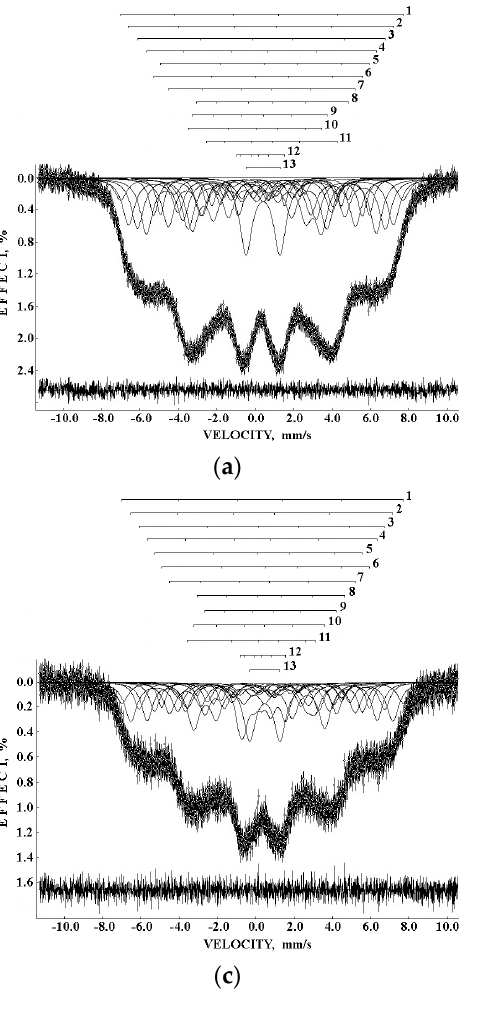
Figure 36. Mössbauer spectra of the as‑prepared γ ‑Fe 2 O 3 ( a , b ) and γ ‑Fe 2 O 3 –DMSA ( c , d ) nanoparticles measured at 295 K ( a , c ) and 90 K ( b , d ) and converted into 2048‑channel spectra. Indicated components 1–13 ( a , c ) and 1–12 ( b , d ) are the results of the best fits. The differential spectra are shown on the bottom. Adapted from Ref. [72] with permission from Elsevier: Spectrochimica Acta, Part A: Molecular and Biomolecular Spectroscopy, Vol. 152, Oshtrakh M.I., Ushakov M.V., Šepelák